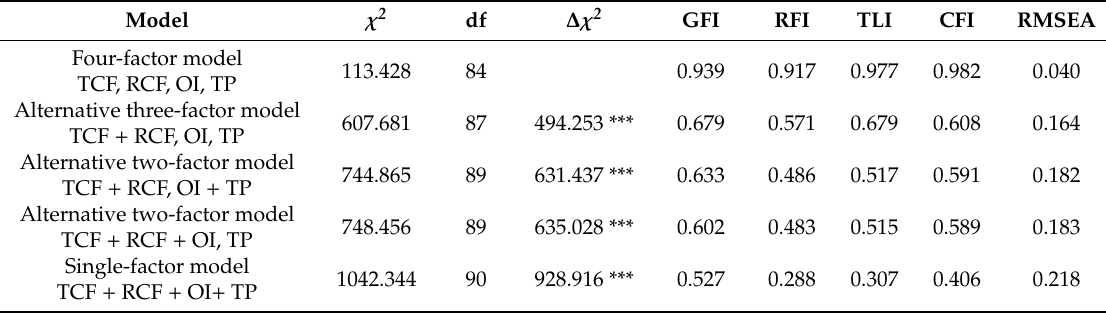
Table 3. Confirmatory factor analysis results of alternative models.